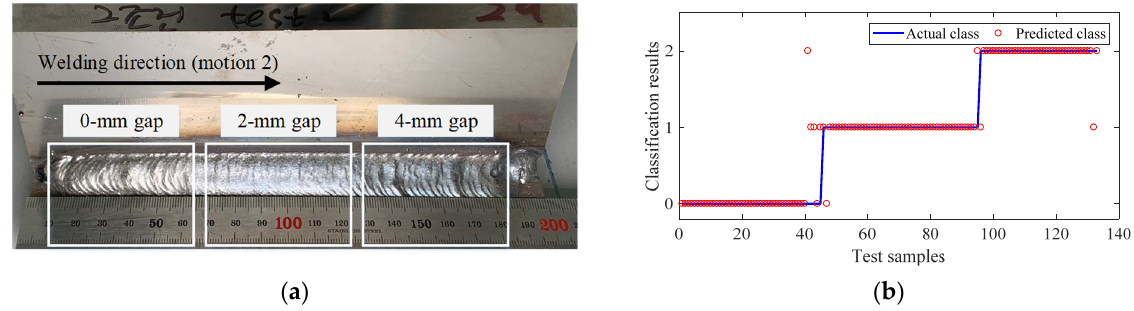
Figure 10. Offline verification results for optimal conditions for 0 mm gap (applied robot motion 1): ( a ) weld bead shape of each weld gap region and ( b ) weld gap classification results. Figure 11. Offline verification results for optimal conditions for 2 mm gap (applied robot motion 2): ( a ) weld bead shape of each weld gap region and ( b ) weld gap classification results.